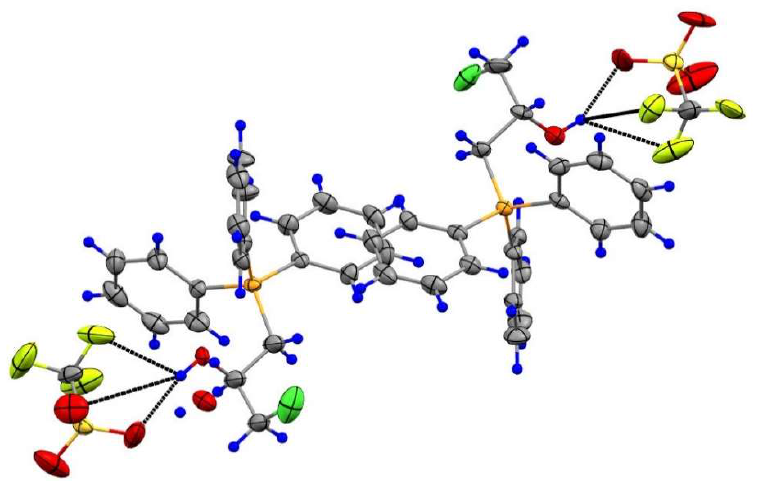
Figure 2. Geometry of independent part of crystal 3a . The hydroxyl group disorder is shown in molecule B. Anisotropic displacement ellipsoids are shown with a 50% probability. Hydrogen bonds are shown as dashed lines.